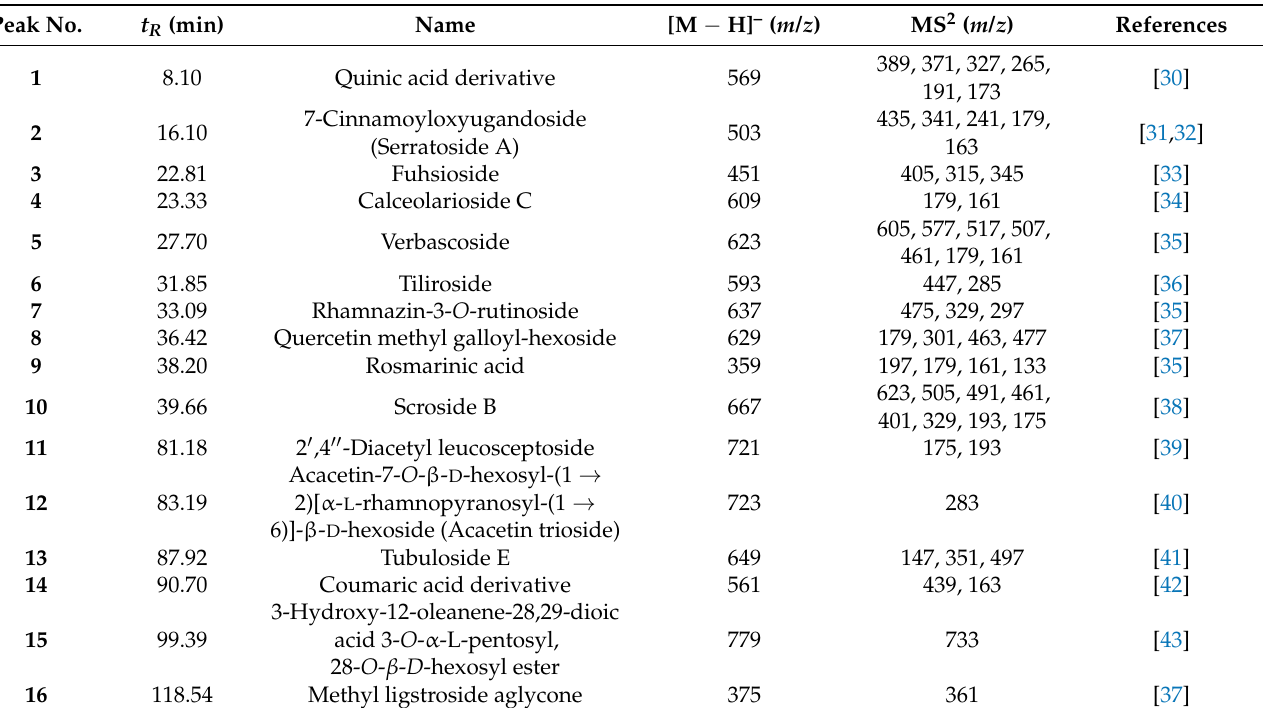
Table 2. Phytoconstituents tentatively identified in the total methanol extract of C. speciosum leaves using HPLC-ESI-MS/MS in the negative ion